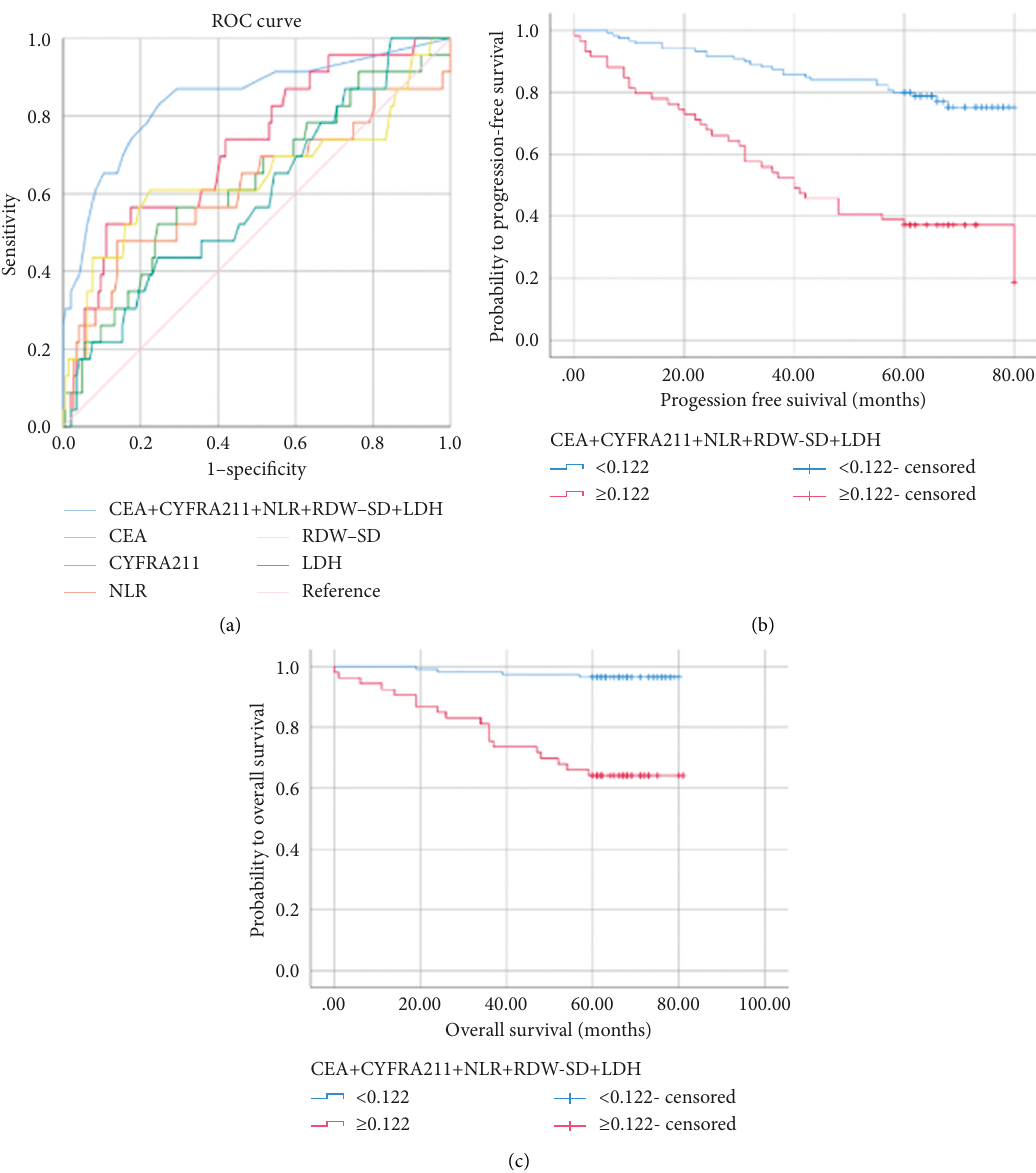
Figure 2: ROC curves for survival prediction. (a) Kaplan–Meier curves for progression-free survival (b) and overall survival (c) probability according to the CEA+ CYFRA211+NLR+RDW-SD +LDH level. CEA: carcinoembryonic antigen; CYFRA211: serum cytokeratin-19 fragment; NLR: neutrophil-to-lymphocyte ratio; RDW-SD: red blood cell distribution width-standard deviation; LDH: lactate dehy- drogenase; AUC: area under the